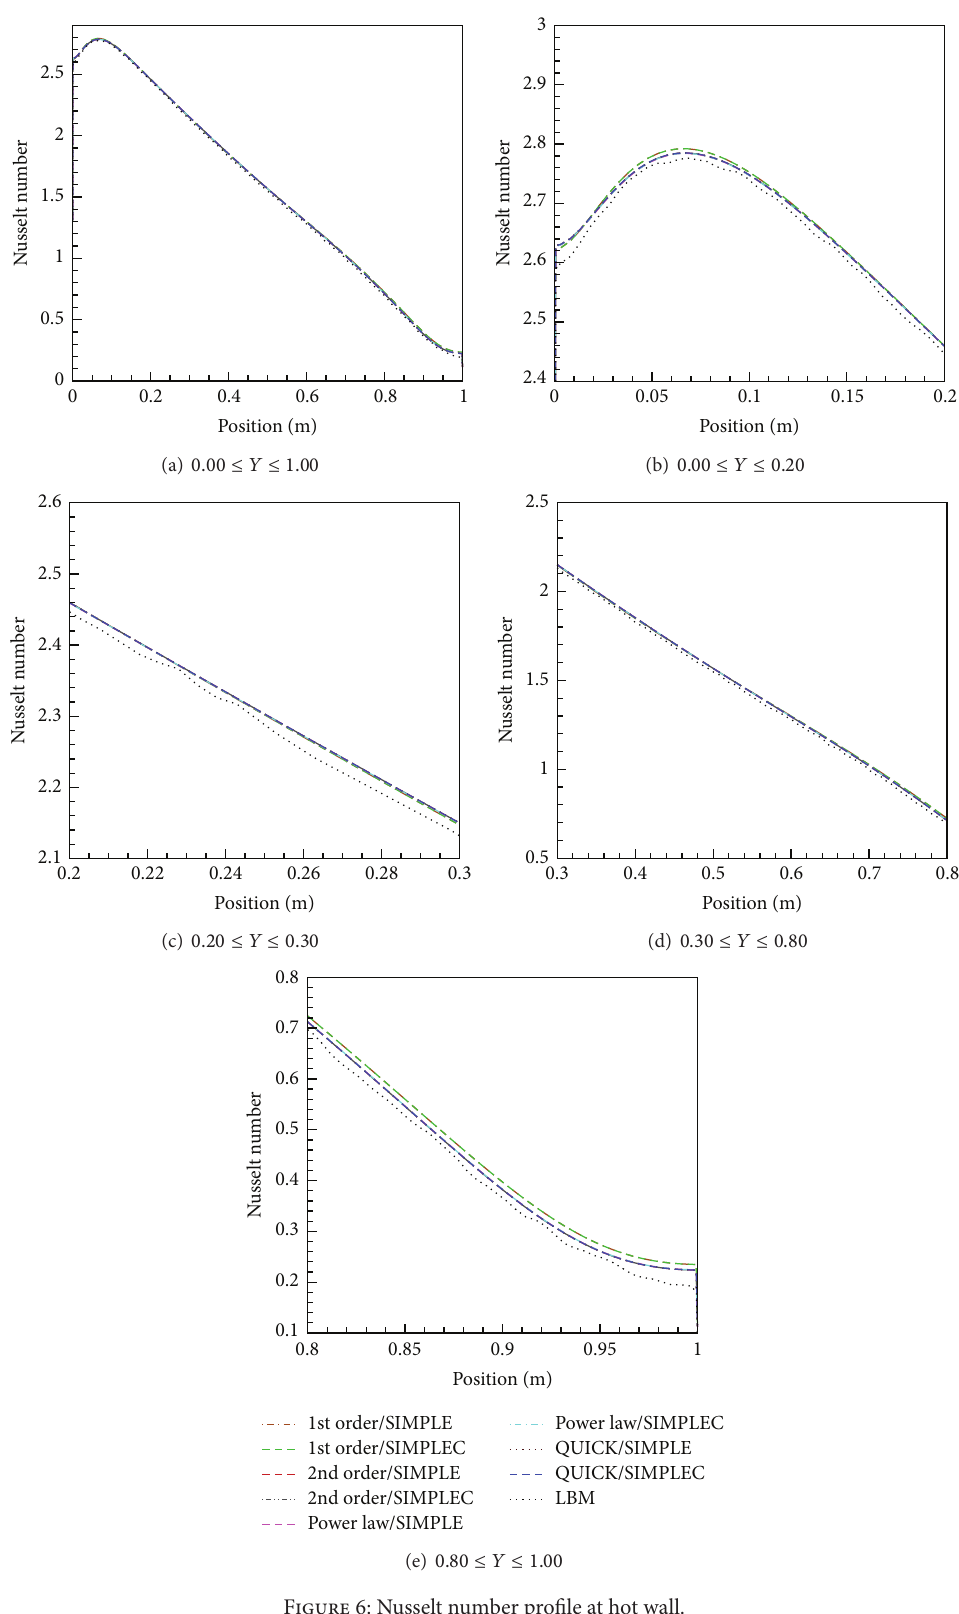
Figure 6: Nusselt number profile at hot